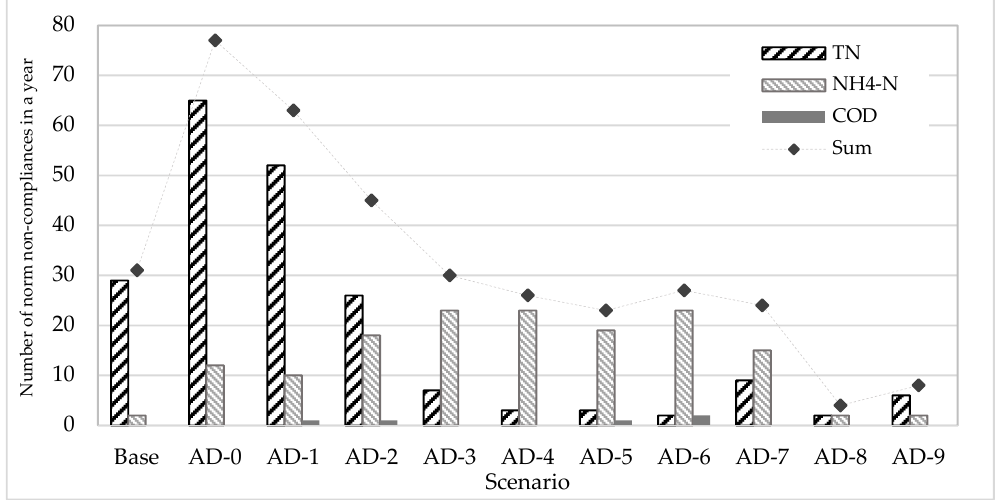
Figure 5. Number of norm non-compliances in a year for the tested strategies.